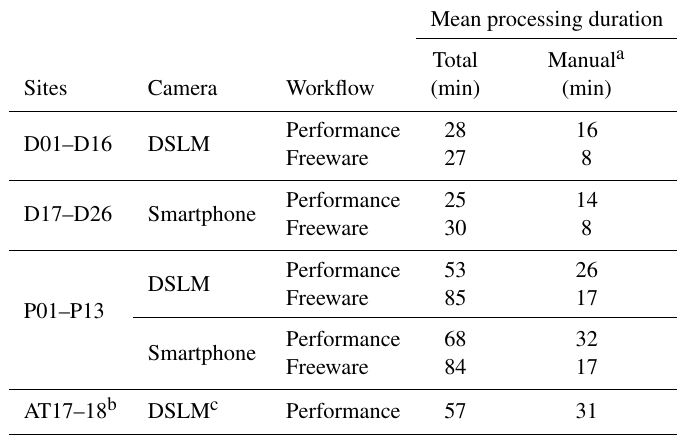
Table B1. Time required to derive watertight models of the soil pits for both workflows and all cameras applied.